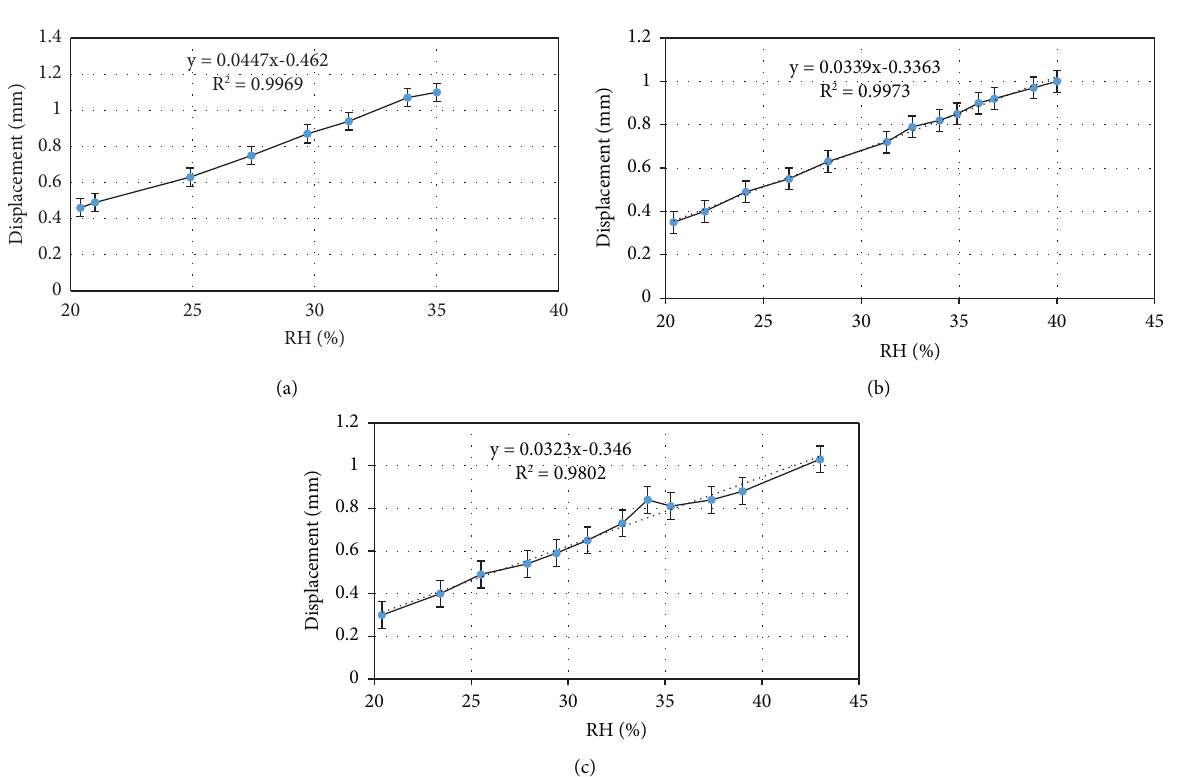
Figure 9: Interference line displacement as a function of RH (%). Film thickness in (a) 70 μ m, (b) 50 μ m, and (c) 20 μ m. Vertical error bars are 0.1mm. Tere are no horizontal error bars because the electronic hygrometer had the reading till the frst digit after the point or tenths of relative humidity integers.